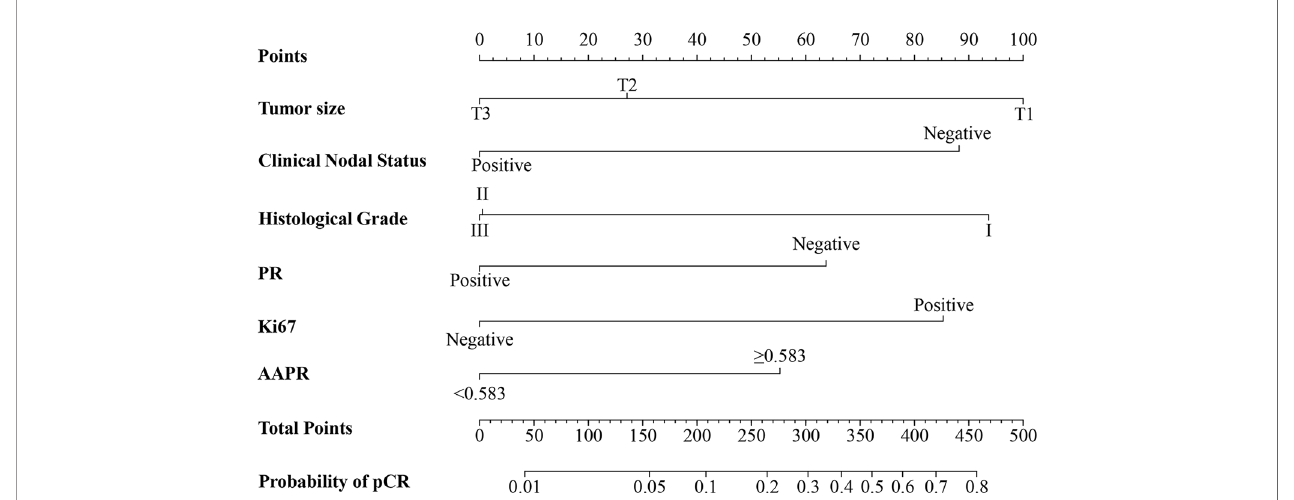
FIGURE 1 | The AAPR-based nomogram for predicting the probability of pCR after NAC in breast cancer patients. PR, progesterone receptor; AAPR, albumin-to- alkaline phosphatase ratio; pCR, pathologic complete